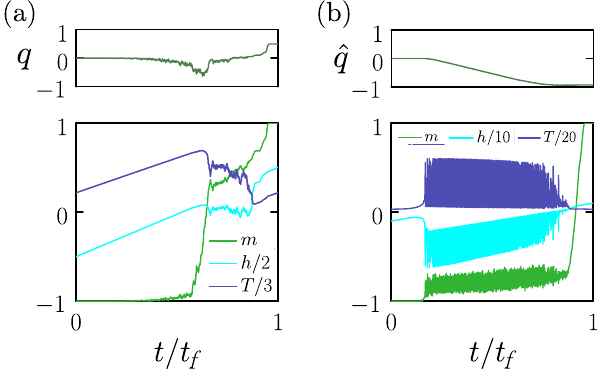
P Δ E replacing Eq. (6) as the order parameter to be minimized. k k